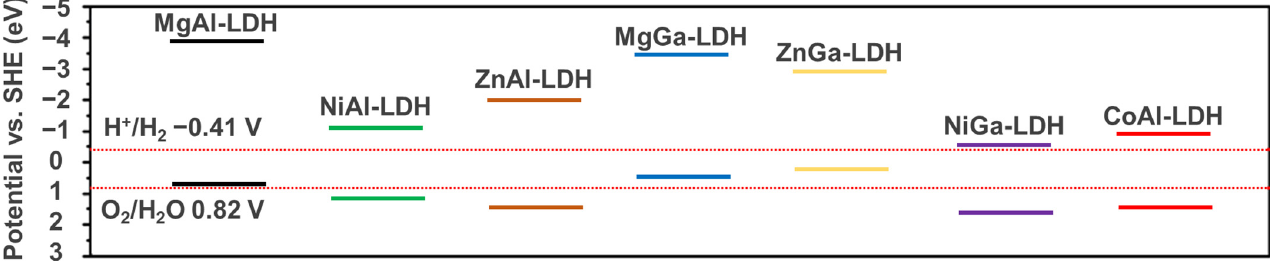
Figure 3. Band potentials of Mg, Zn, Co, Ni based LDHs [57].